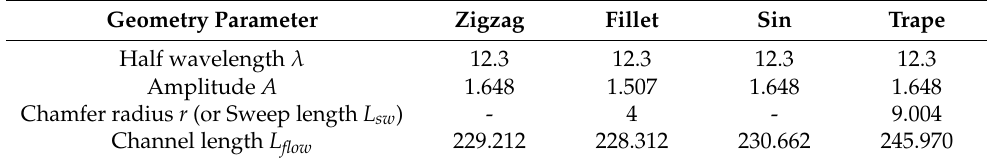
Table 1. Detailed geometry coefficients of the four wavy channels. All length units are in mm. Geometry Parameter